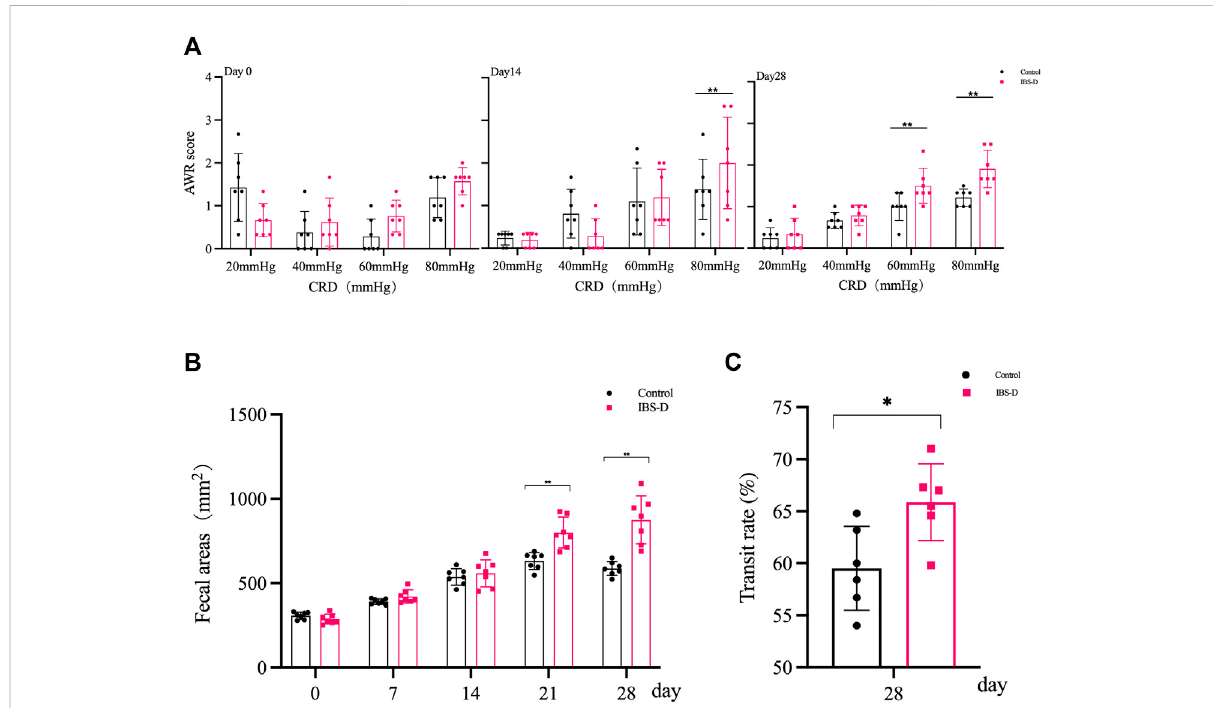
FIGURE 1 EvaluationoftheIBS-Dmodel. (A) Abdominalwithdrawalre fl exassessmentinIBS-Drats.TheAWRscoreswereusedtoassessvisceralsensitivityinIBS-Dratsat baseline,day14andday28. (B) Thedefecationareaevaluateddiarrheasymptomsatbaseline,day7,day14,day21,andday28indifferentgroups. (C) Theintestinal transit rate revealed the changes in colon motility among model groups. Data are presented as mean ± SD ( n = 6). ** p < 0.01 vs. controls, * p < 0.05 vs.